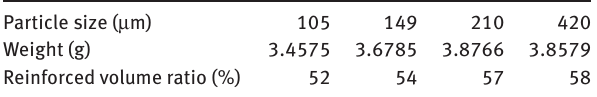
powders with different particle sizes 2